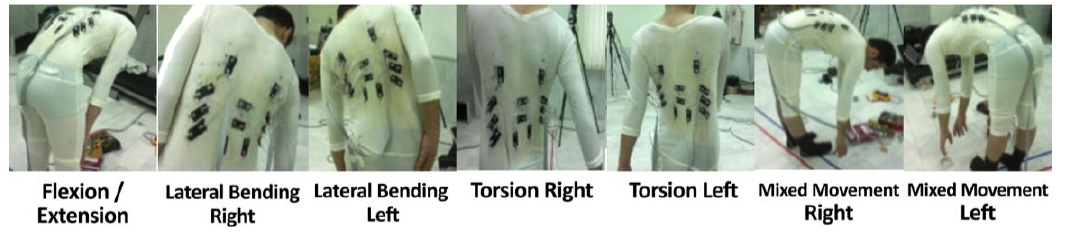
Figure 7. Seven tasks performed for the calibration of the TMS. Each participant performed five planar movements and two multiplanar movements.